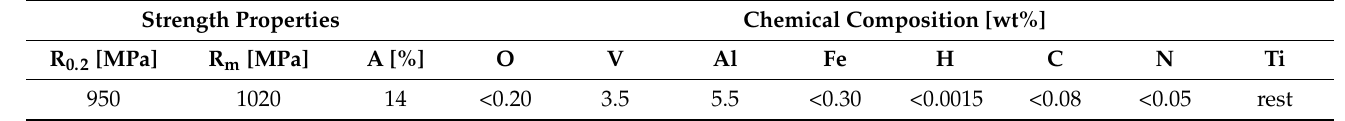
Table 2. Strength properties and chemical composition of the Ti6Al4V